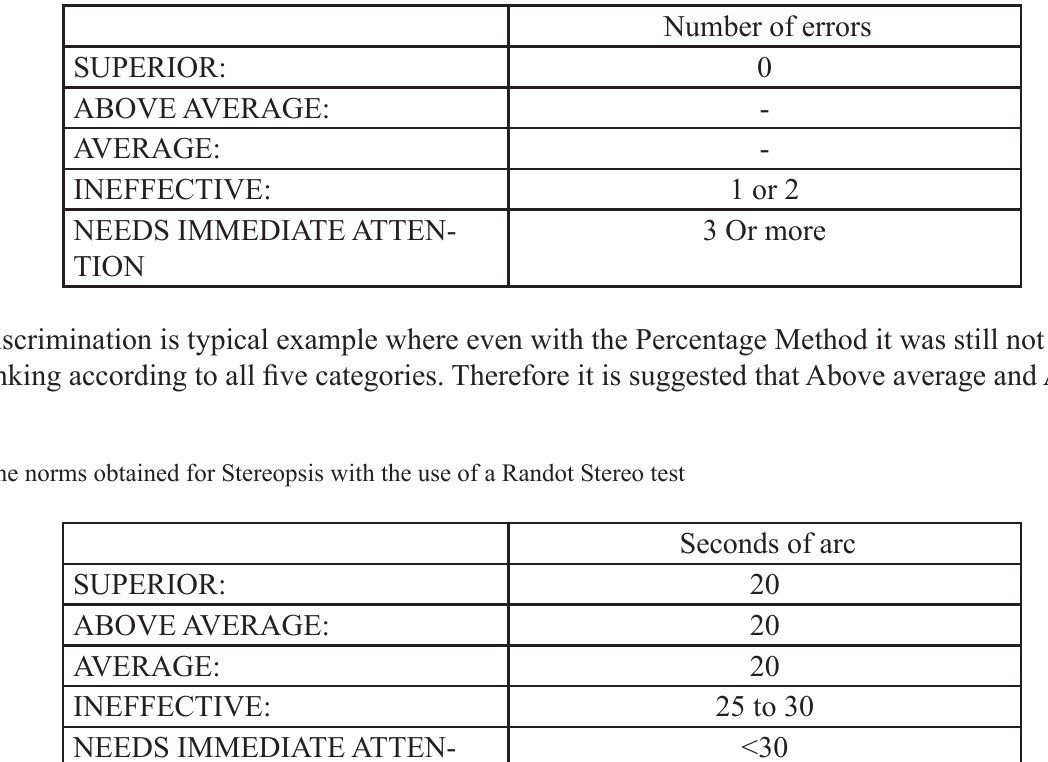
Table 6: The norms obtained for Focus Flexibility (Accommodation) with the use of +2.00/ – 2.00 dioptre at 40 cm and a pl/ – 2.00 dioptre flippers at 6 metres